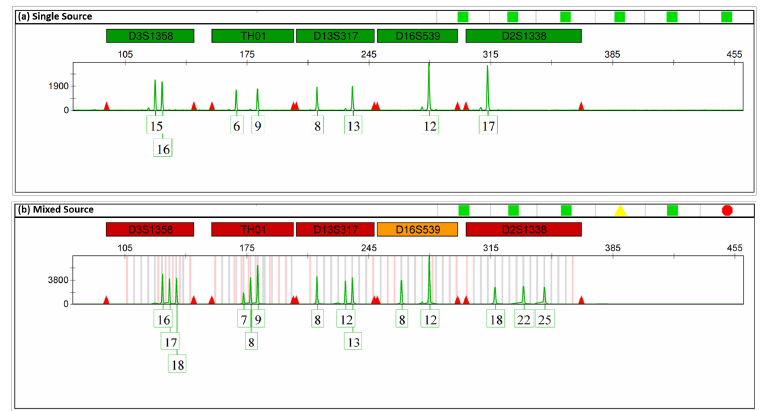
Figure 6. Single vs. mixed